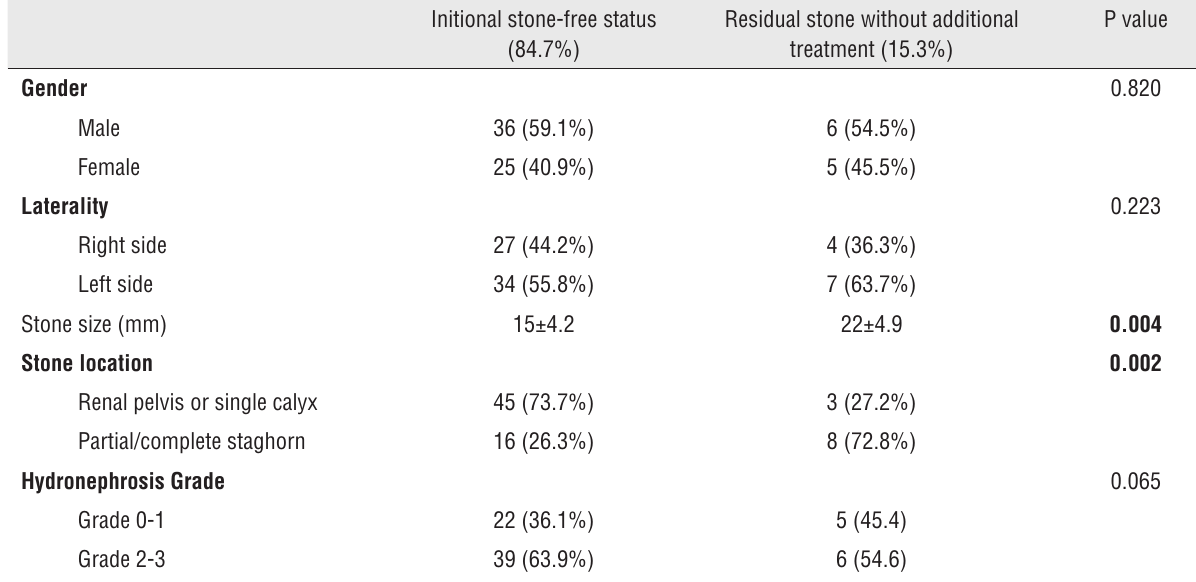
Table 4 - Factors that affect the stone free status of the patients.